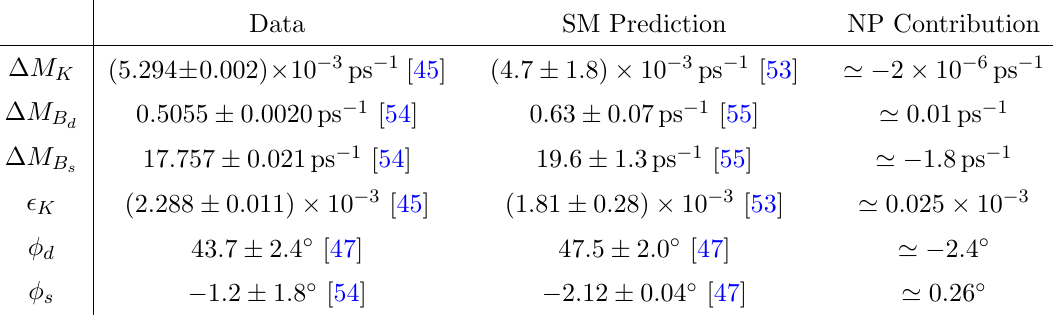
Table 2 . Experimental measurements and SM predictions for meson mixing observables. The SM prediction for (cid:1) M K and its uncertainty refers to the short distance contribution. To account for long distance e(cid:11)ects, we use (cid:1) M SM = (cid:1) M exp (1 (cid:6) 0 : 5) in our numerical analysis. Also shown are K K the NP contributions corresponding to the benchmark point